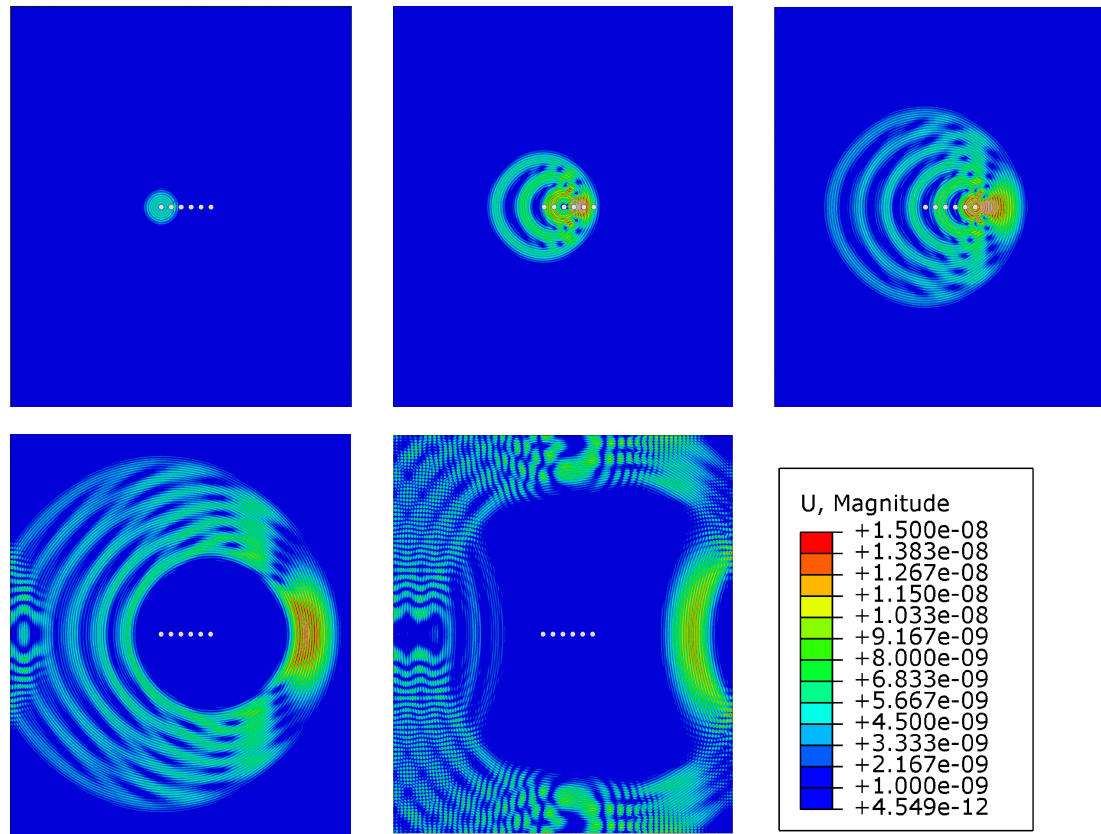
Figure 2. Transmission beamforming simulation using a linear phased-array of 6 piezoelectric wafer active sensors (PWASs) (white circles) focusing horizontally towards right of the